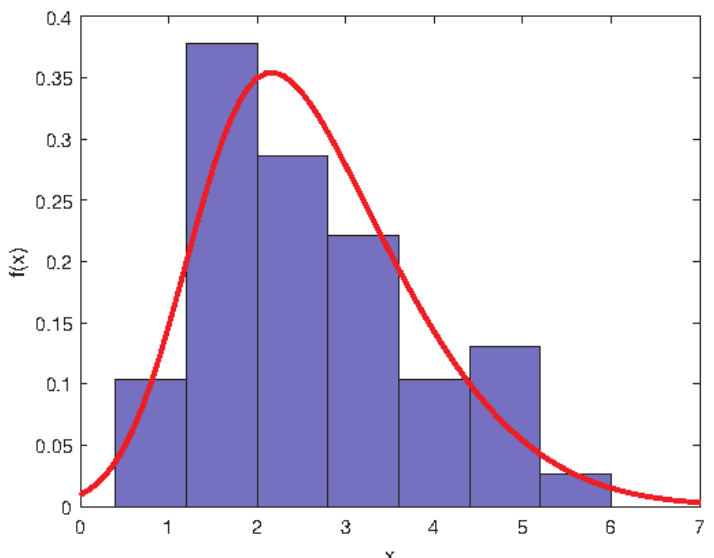
Figure 2. Frequency histogram of the LAI with superimposed skew-normal density